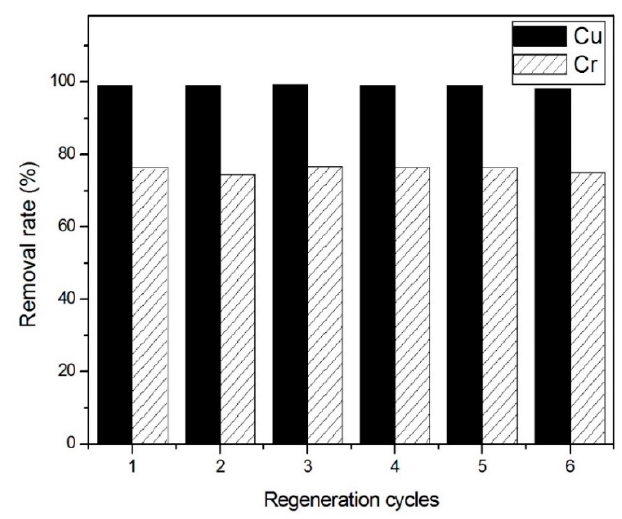
Figure 10. Regeneration studies of Fe 3 O 4 for the adsorption capacity of Cr(VI) and Cu(II).